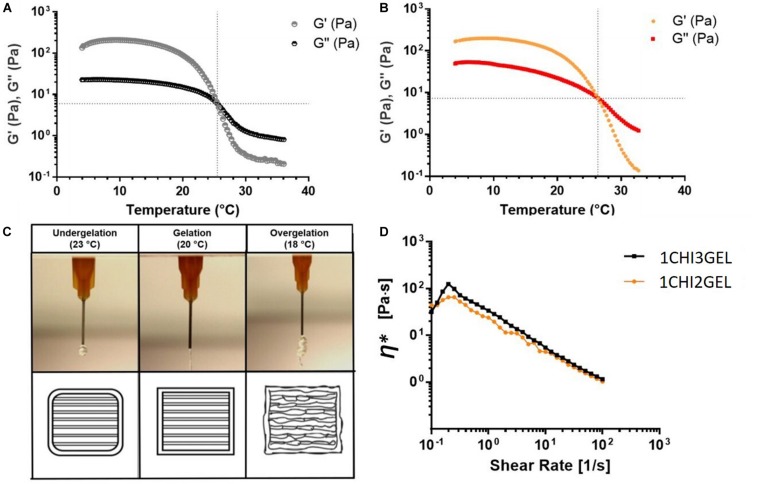
Rheological characterization of chitosan – gelatin blends. Storage (G′) and loss (G″) moduli at varying temperatures for (A) 1CHI2GEL, and (B) 1CHI3GEL. (C) Extrusion of the gel at varying temperatures (18, 20, 23°C). (D) Complex viscosity η* behavior in function of the shear rate for 1CHI2GEL and 1CHI3GEL.